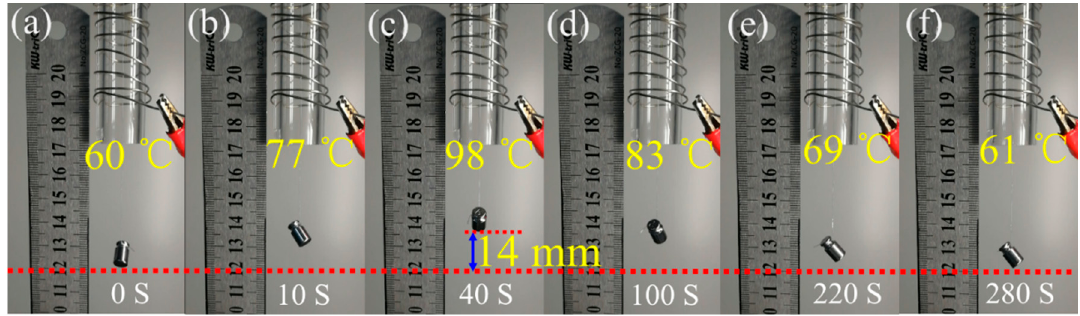
Figure 9. Digital photographs showing the 2W-SME of the EVA-10M fiber under constant stress.